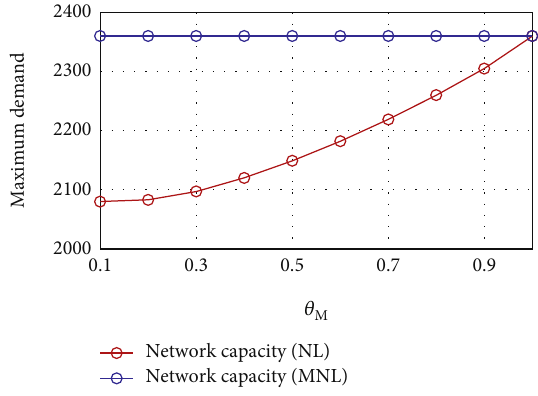
Figure 11: E ff ect of mode similarity on network capacity.